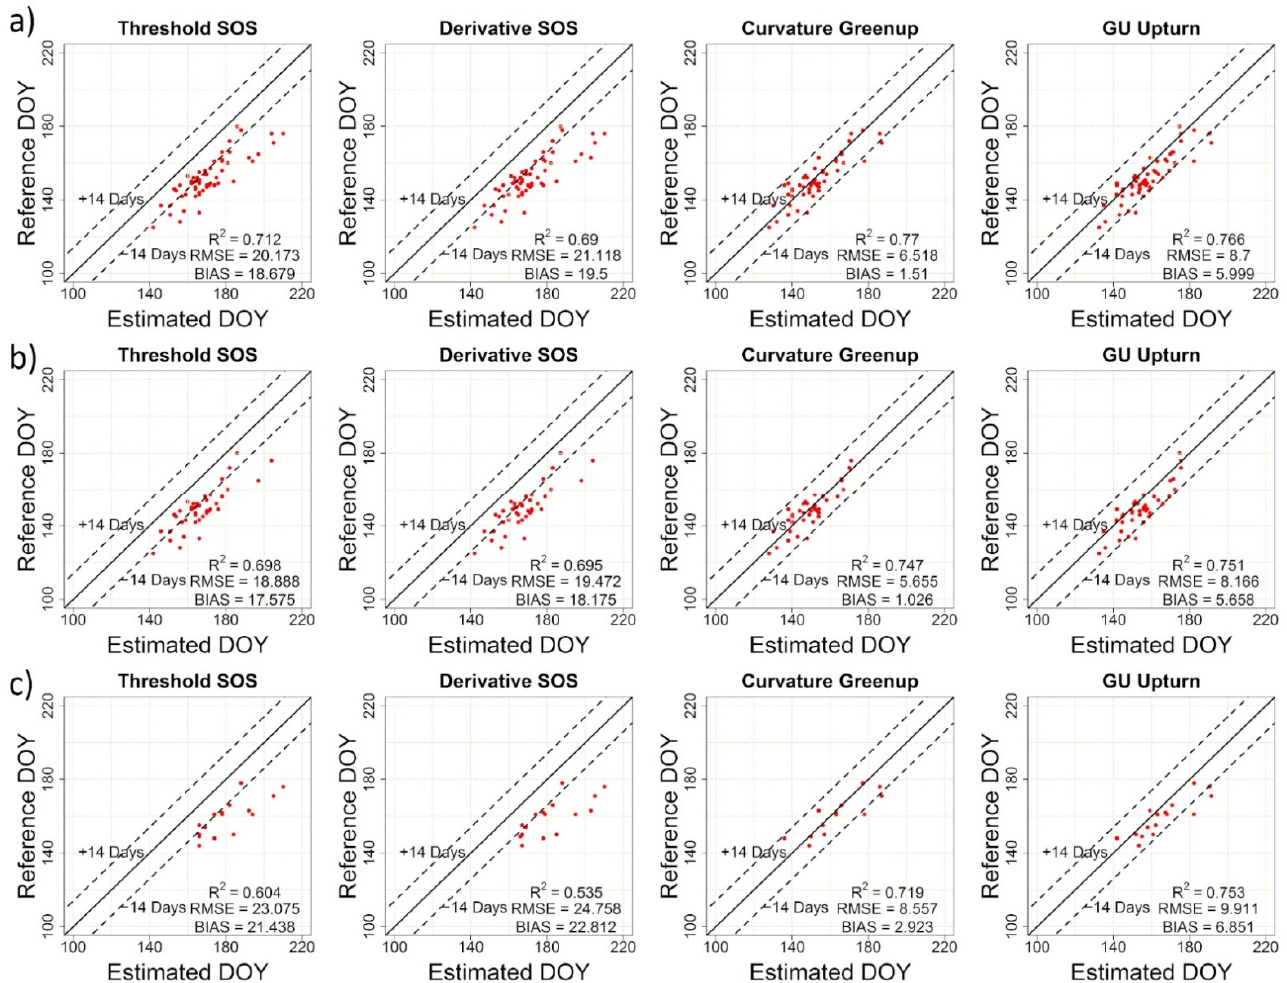
Figure 6. The comparisons between the PhenoCam GCCbased transition date estimates of the greenness rising period and the visually observed emergence for ( a ) both corn and soybean, ( b ) corn, and ( c ) soybean, using the four phenophase analysis methods.